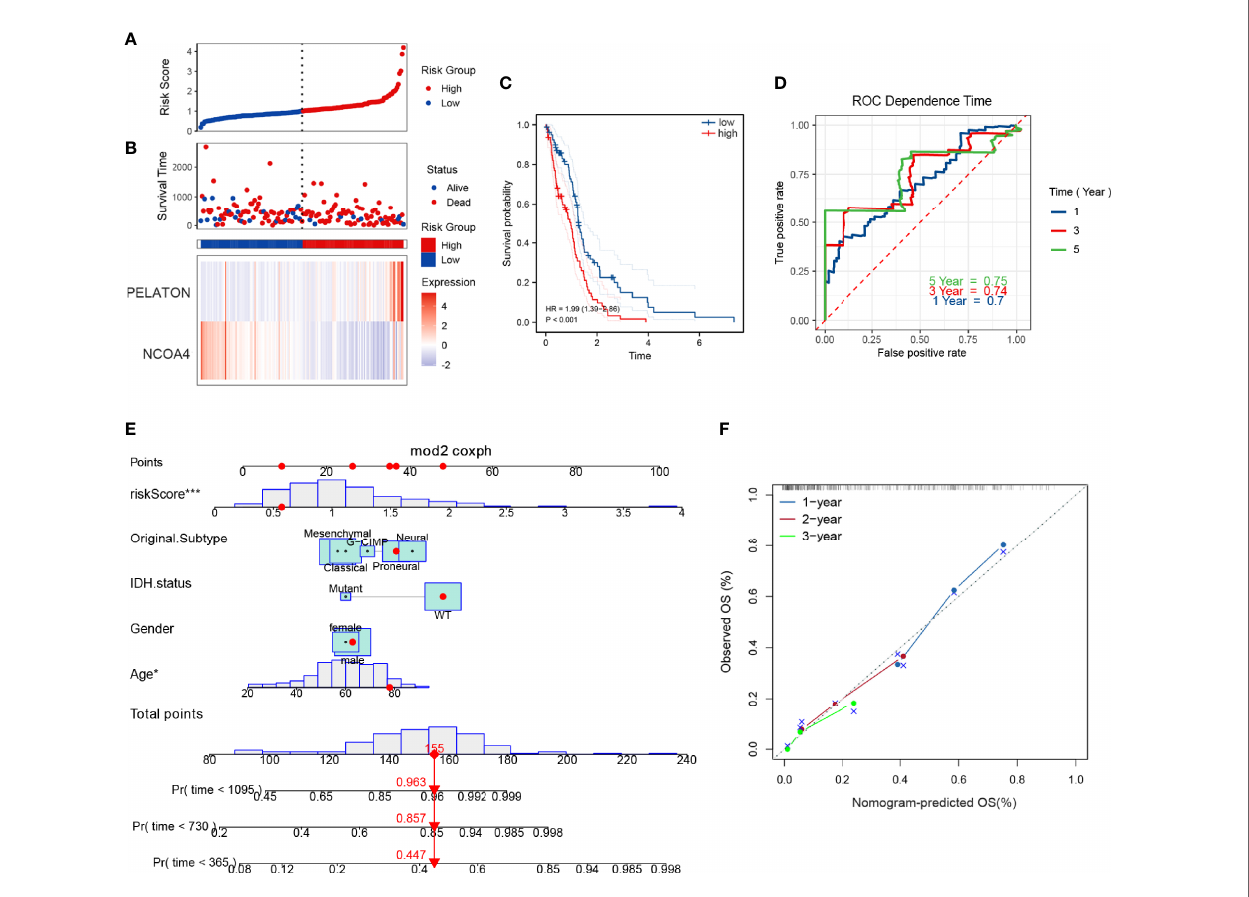
FIGURE 2 | Ferroptosis risk prognosis model with NCOA4 and PELATON. The distribution of risk factors (A, B) , Kaplan – Meier survival analysis (C) , and time-dependent ROC curves at 1, 3, and 5 years (D) between patients at high and low risk based on the NCOA4 and PELATON prognostic models in the TCGA discovery set. (E) Nomogram integrating the ferroptosis risk score, age, sex, original subtype and IDH status. (F) Calibration curve for predicting OS at 1, 2 and 3